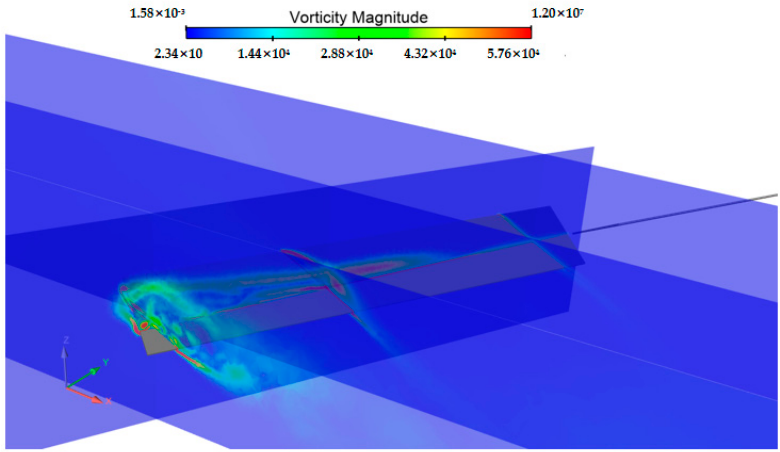
Figure 10. Contour of vorticity magnitude of case 3.